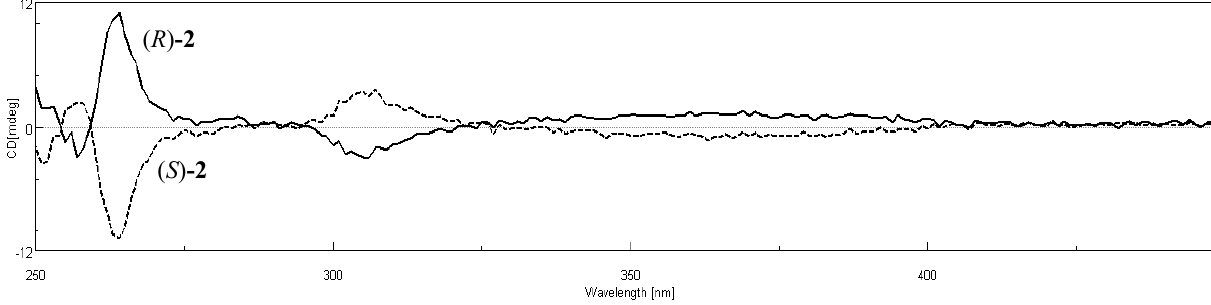
Figure 1. CD spectra of ( R )- and ( S )- 2 in CHCl